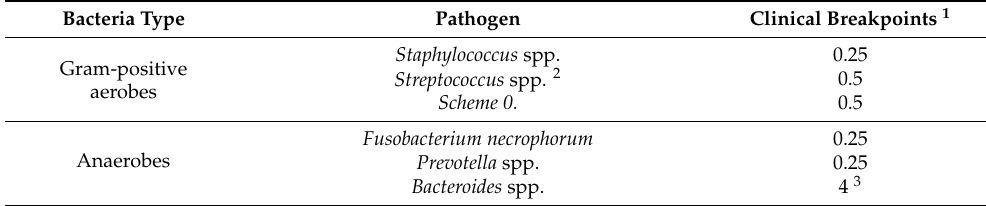
Table 3. Clinical breakpoints for clindamycin’s most relevant bacterial pathogen